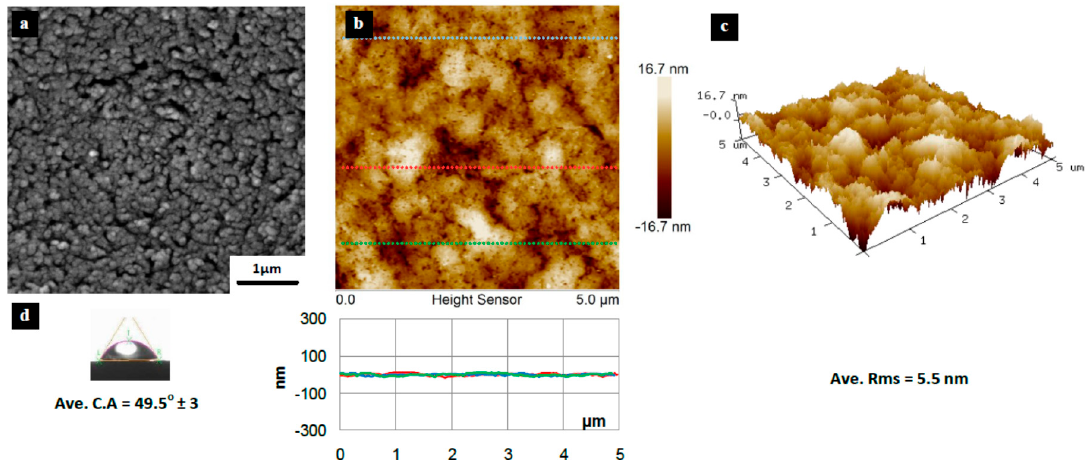
Figure 4. Surface characteristics of as received PES substrate (20 nm pore size), ( a ) SEM micrograph; ( b ) 5 × 5 µm 2 AFM image (top) and three section profiles (bottom) with an average RMS equal to 5.5 nm; ( c ) 3D profile for the selected area; ( d ) surface contact angle (CA) with an average equal to 49.5° ± 3.